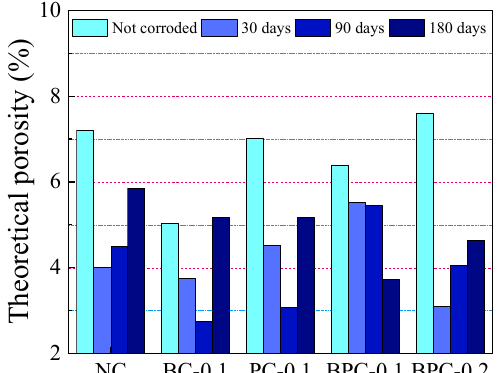
Figure 11. Theoretical porosity variation at 4 mm from the surface of the HBPRC.